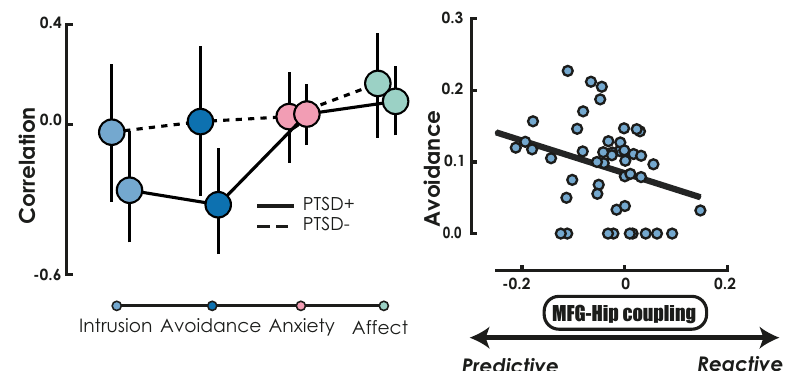
Fig. 5 Correlation between control imbalance and PTSD symptoms. Left panel: correlations between the balance of memory control over the hippocampus (i.e., predictive – reactive control coupling parameters) and mental health features for PTSD + (solid line) and PTSD − (dashed line). The large circles represent the Spearman correlation coef fi cients and the error bars represents 95% bootstrapped CI of the correlation (and thus indicate signi fi cance when they do not overlap with zero). Anxiety-related transdiagnostic features included anxious arousal, dysphoric arousal, and general anxiety, while affect-related transdiagnostic features included anhedonia, mood, and depression. Right panel: relationship between control imbalance in the whole hippocampus and avoidance symptom severity (adjusted for total symptom severity). N sample size = 55 participants with